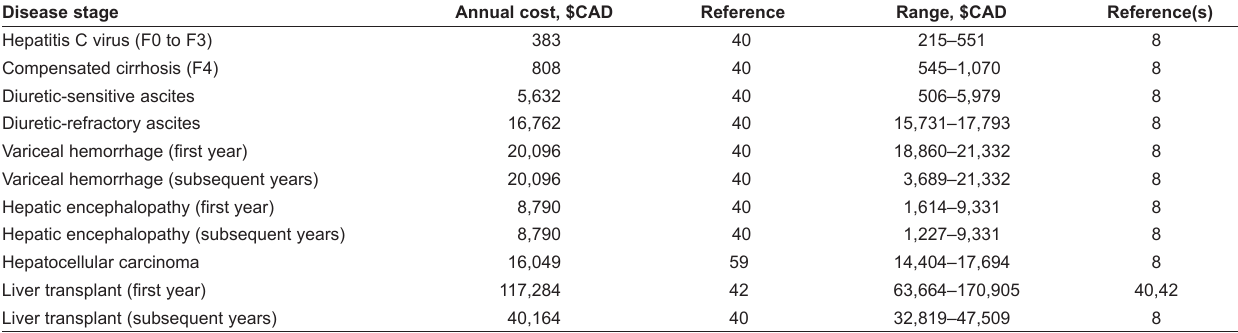
TAble 3 Incremental costs of hepatitis C virus infection according to disease stage used in the model Disease stage